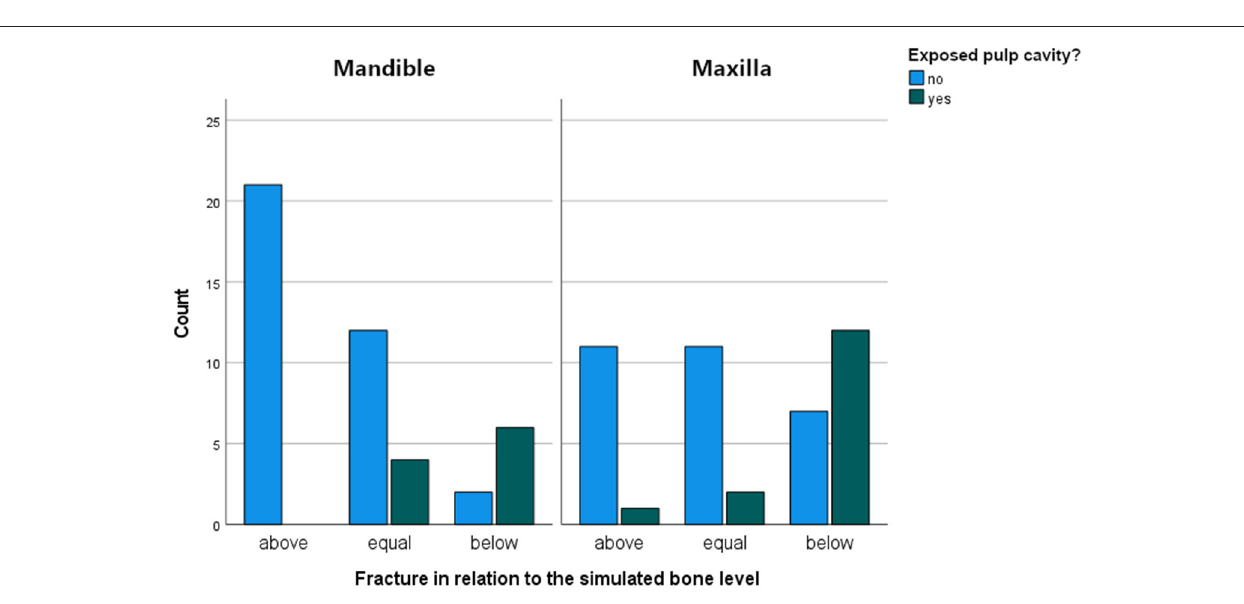
(Triadan number, the site of impact (SD-PH 1-5), dimensions of the occlusal surface) of the tooth were taken into